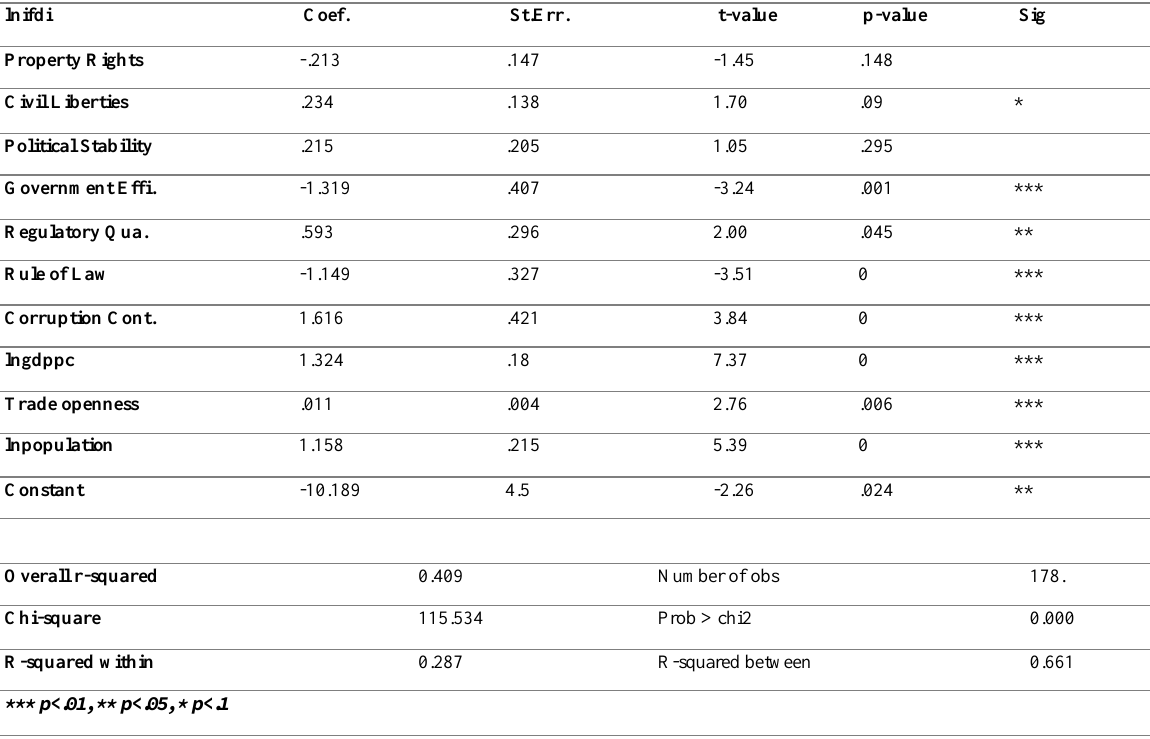
Table 4: Random Effect Regression Results (Excluding BRIC Countries) lnifdi Coef. St.Err. t-value